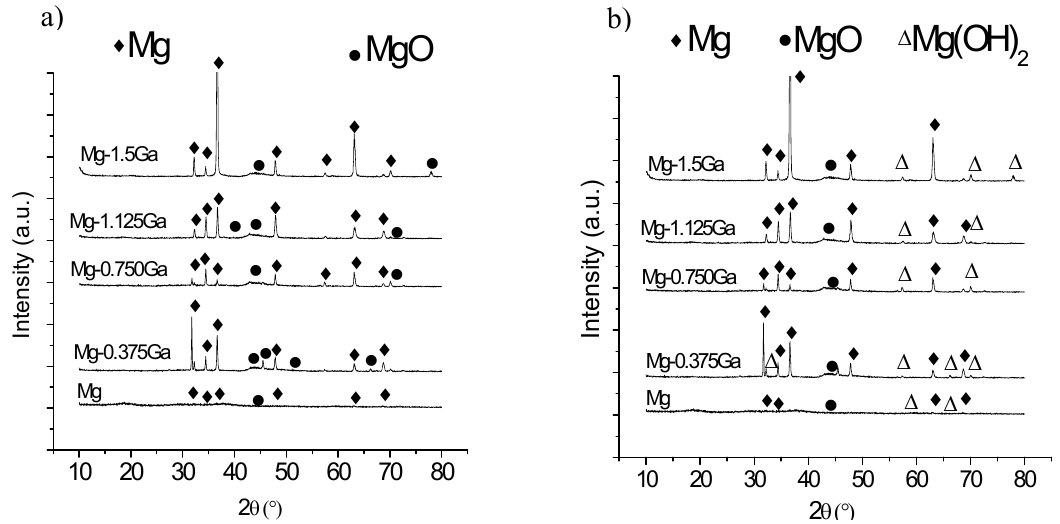
Figure 5. XRD patterns of pure Mg and Mg-Ga alloys after ( a ) 168 and ( b ) 672 h of immersion in SBF.